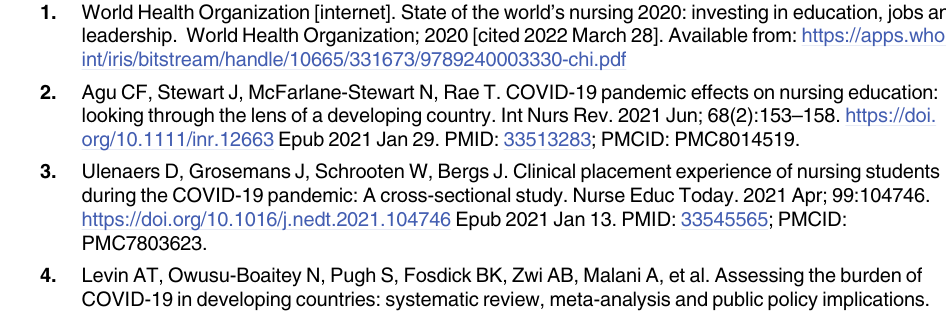
S1 Table. PRISMA-ScR checklist. S2 Table. Quality appraisal of the articles. S3 Table. The results of included